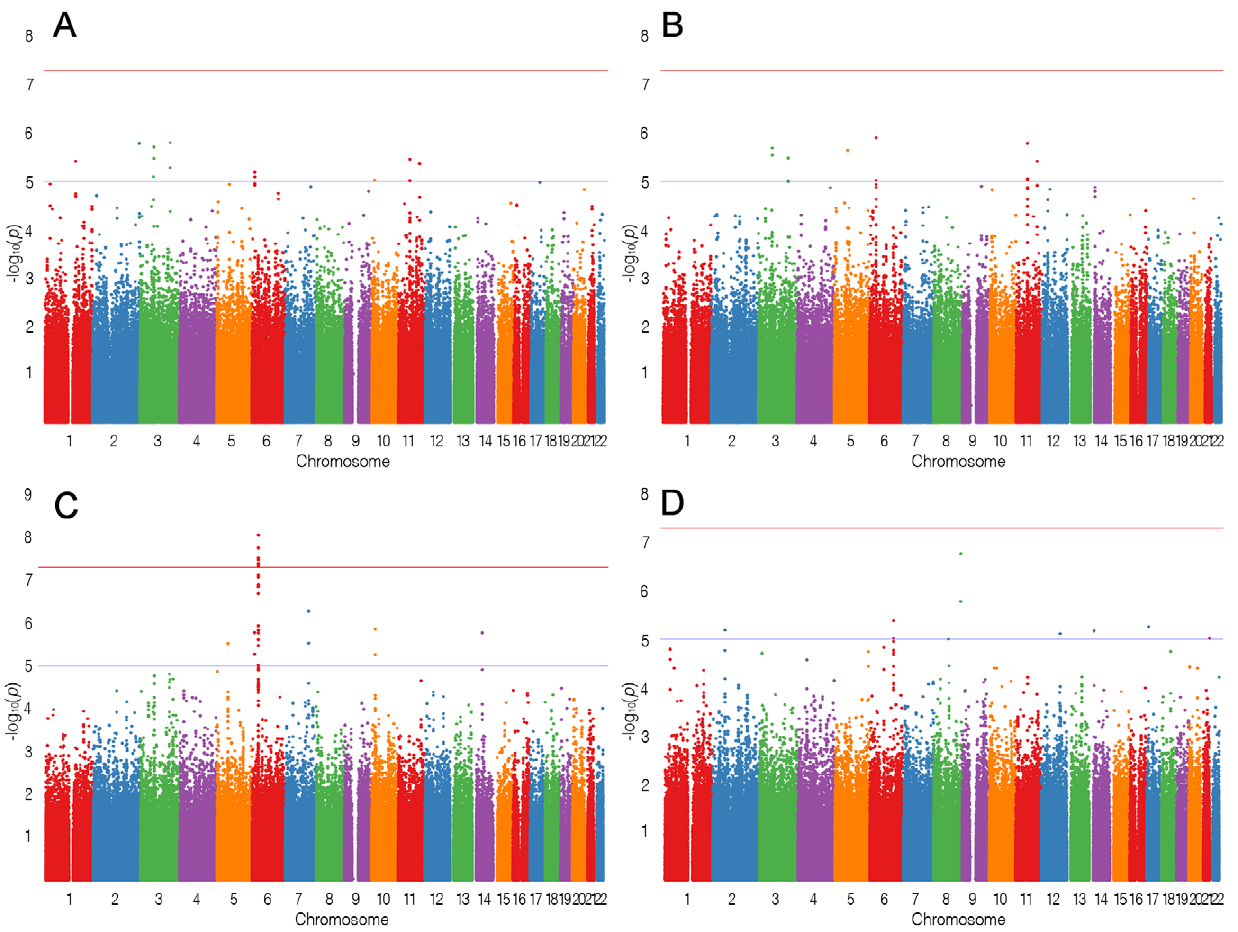
Figure 1. Manhattan plots. Manhattan plots for (A) LYM, (B) NHL, (C) FL, (D) DLBCL. The blue line shows suggestive association and the red line genome-wide association. X-axis labels correspond to chromosomes, Y-axis shows 2 log 10 (P) from logistic regression.